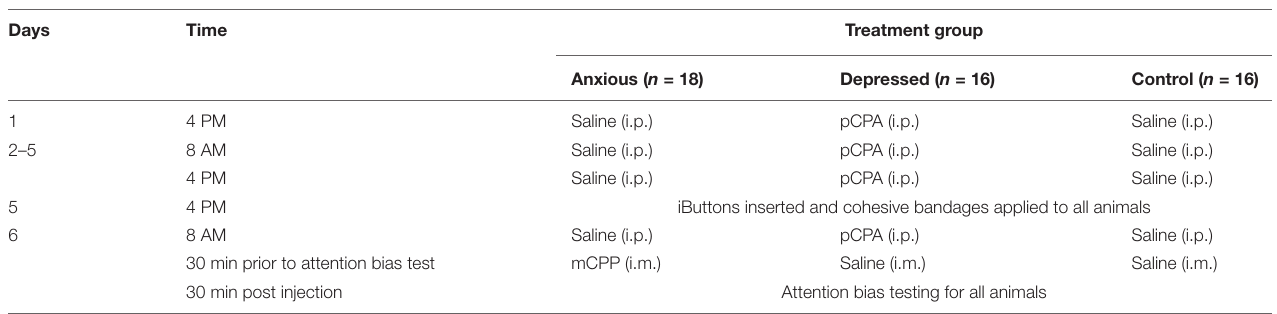
TABLE 1 | Summary of drug treatments during the main